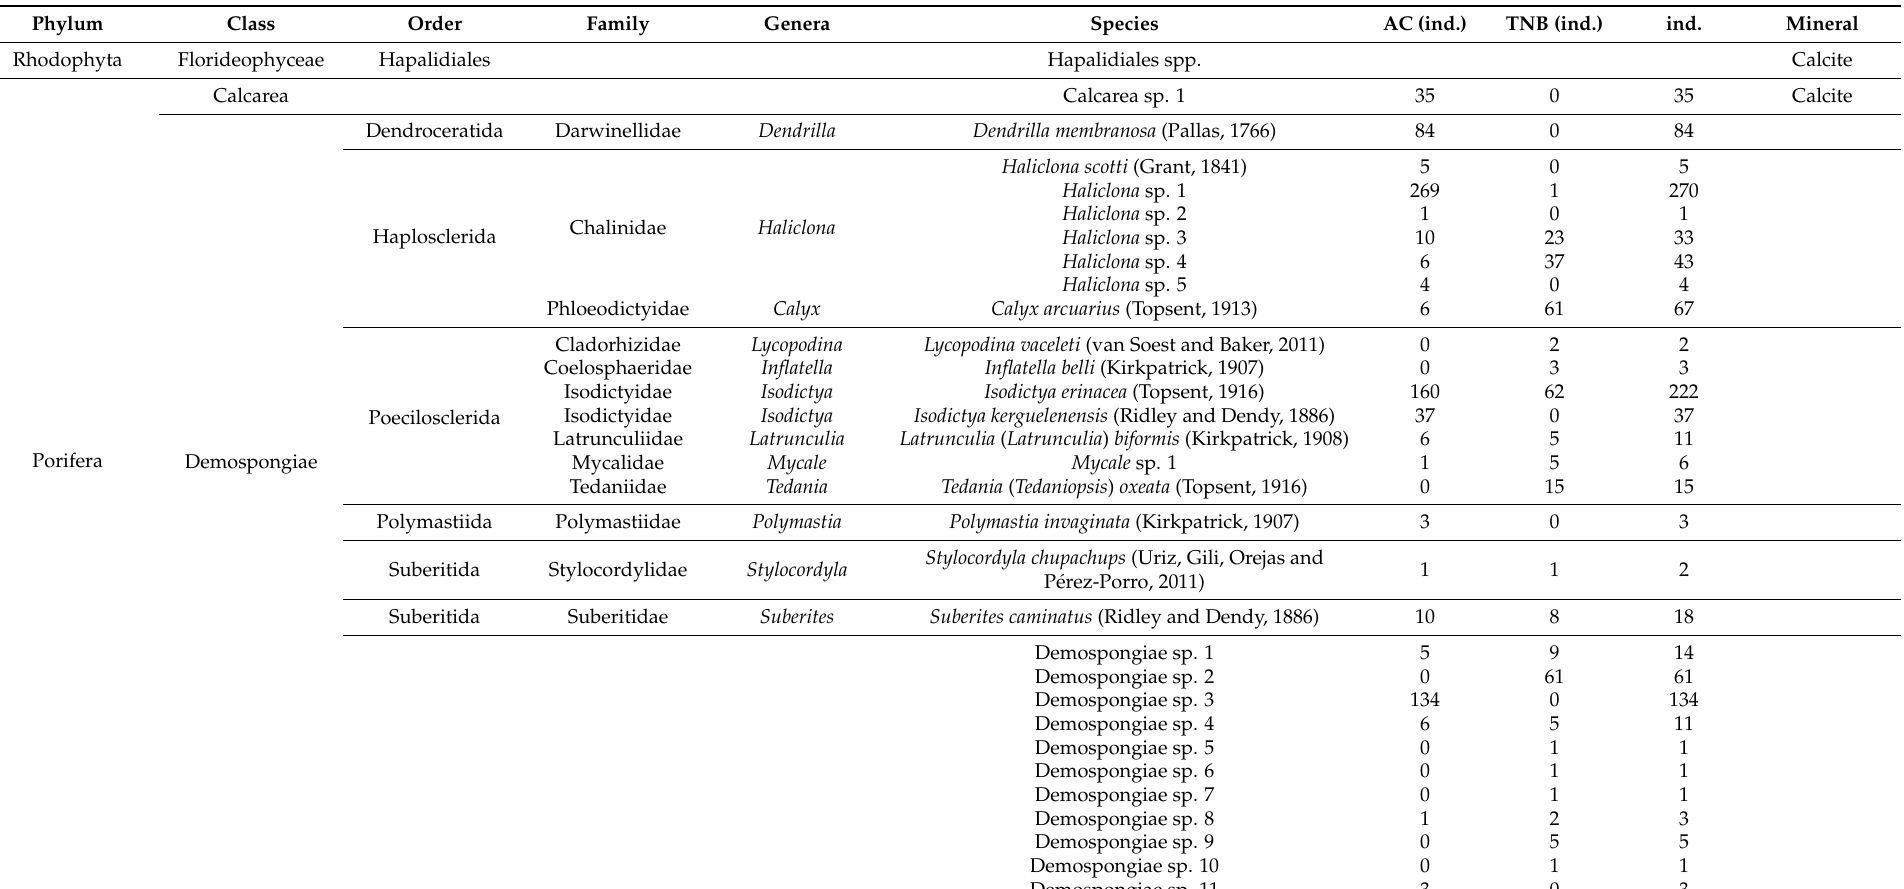
Table 3. Summary of the taxa identified. List of taxa identified in the ROV dives. The number of individuals counted and the skeleton mineralogy of calcifier organisms are also reported. AC refers to the “Adelie Cove” site; TNB refers to the “Terra Nova Bay”